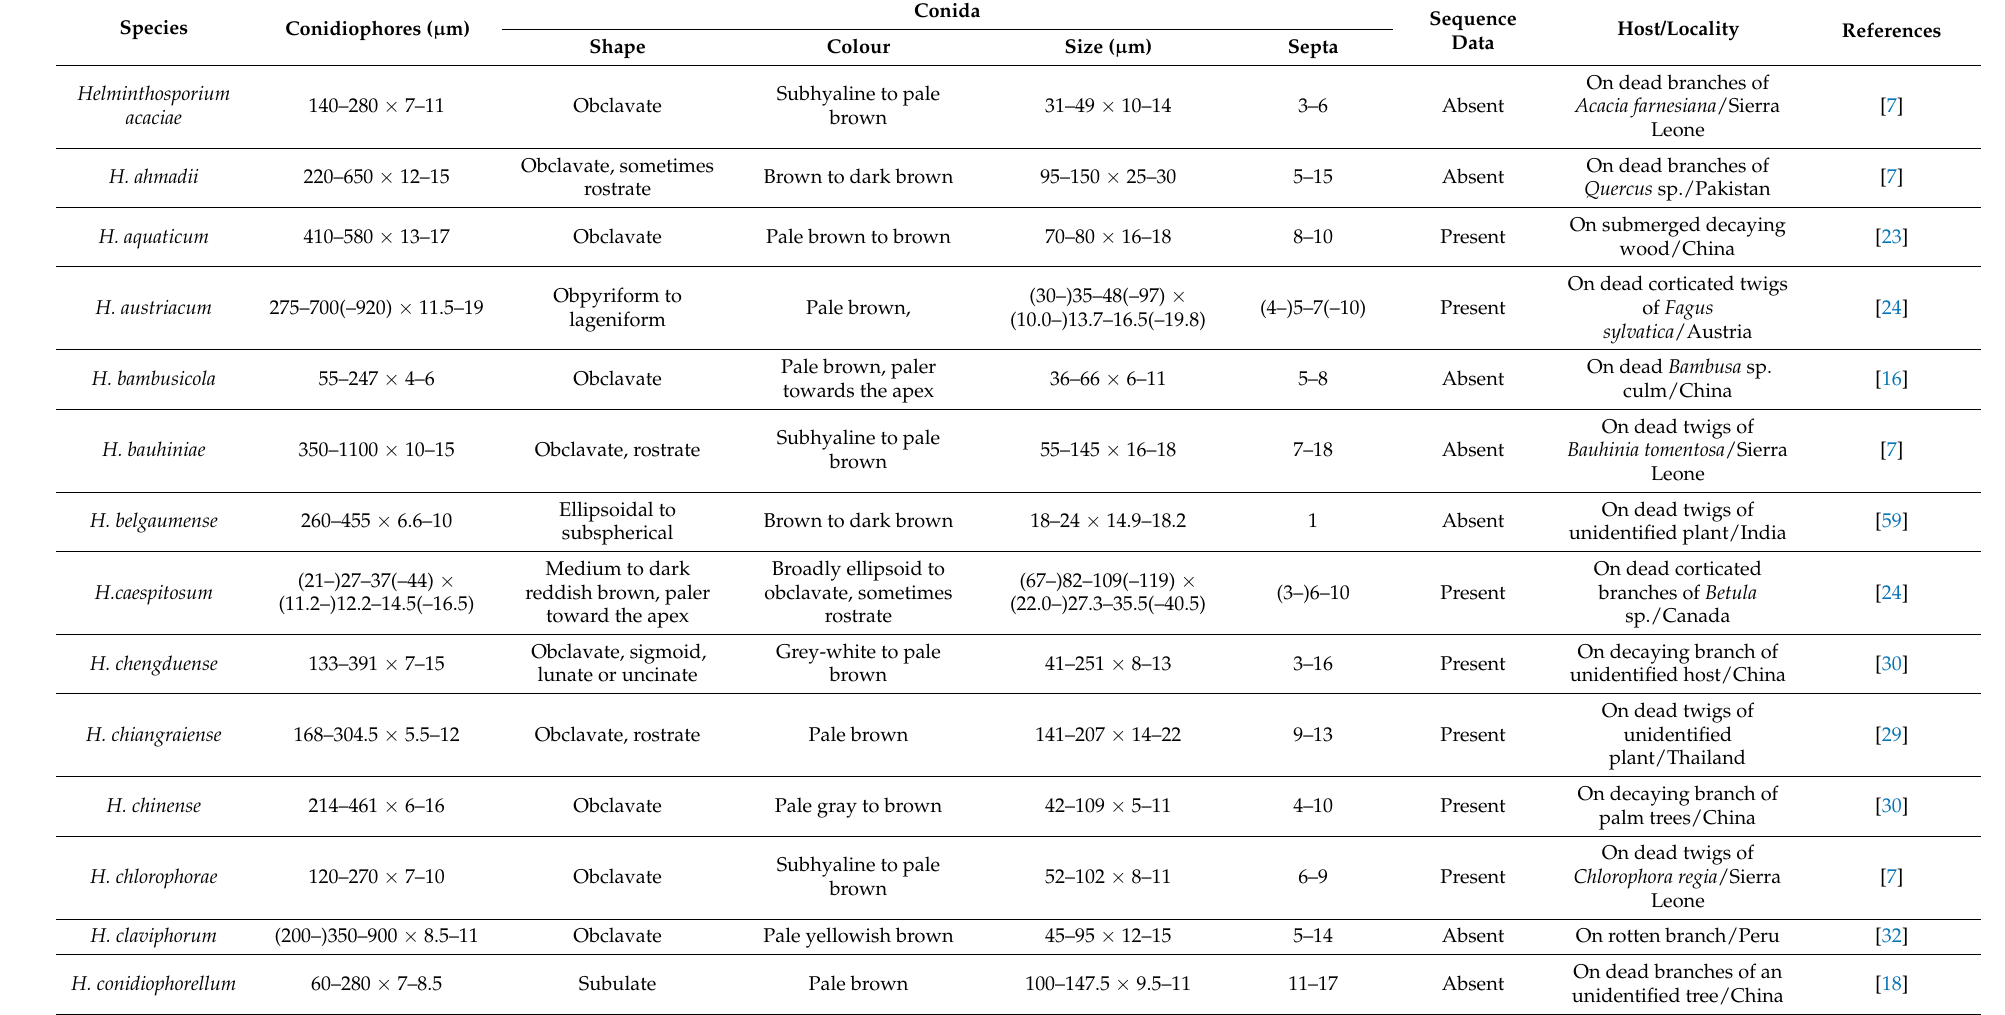
Table 2. Synopsis of morphological characteristics, sequence data, host and locality compared across accepted Helminthosporium